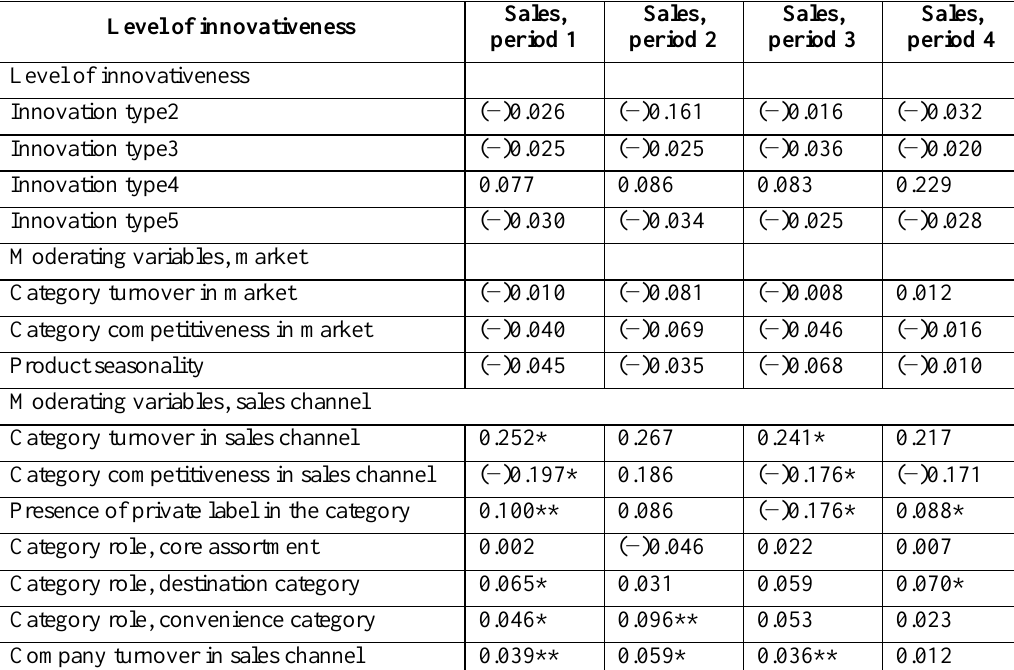
Table 2 . Factors, moderating link between different levels of product innovations and sales performance, standardized β coefficients, adjusted R-sq = 0.11 (created by the